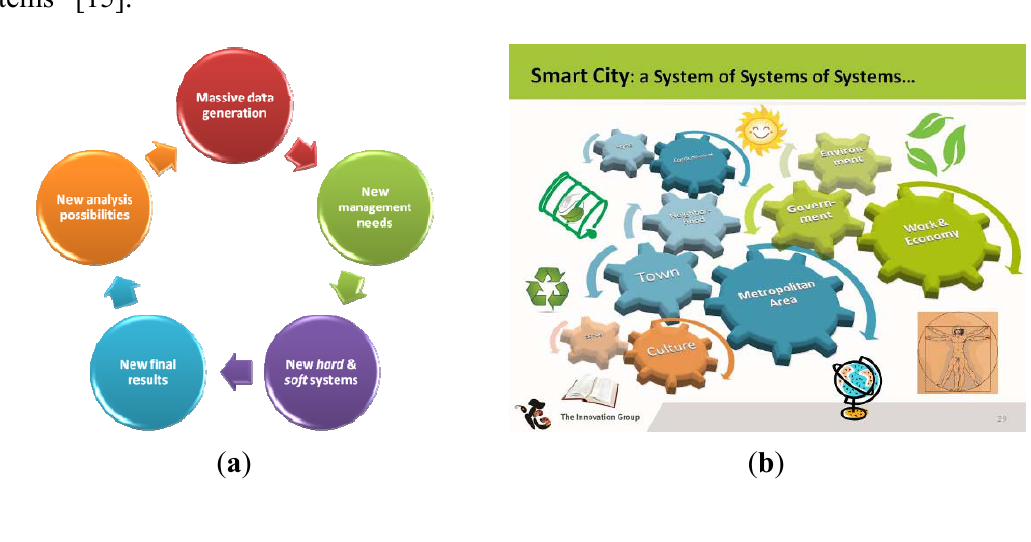
Figure 1. A few schemes of Smart Cities found online, in which people do not